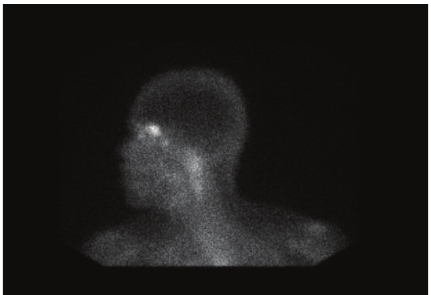
Figure 2: This image from the gallium scan demonstrates symmet- ric increased uptake in the lacrimal glands and the parotid gland. Increased gallium uptake is suggestive of an inflammatory process such as